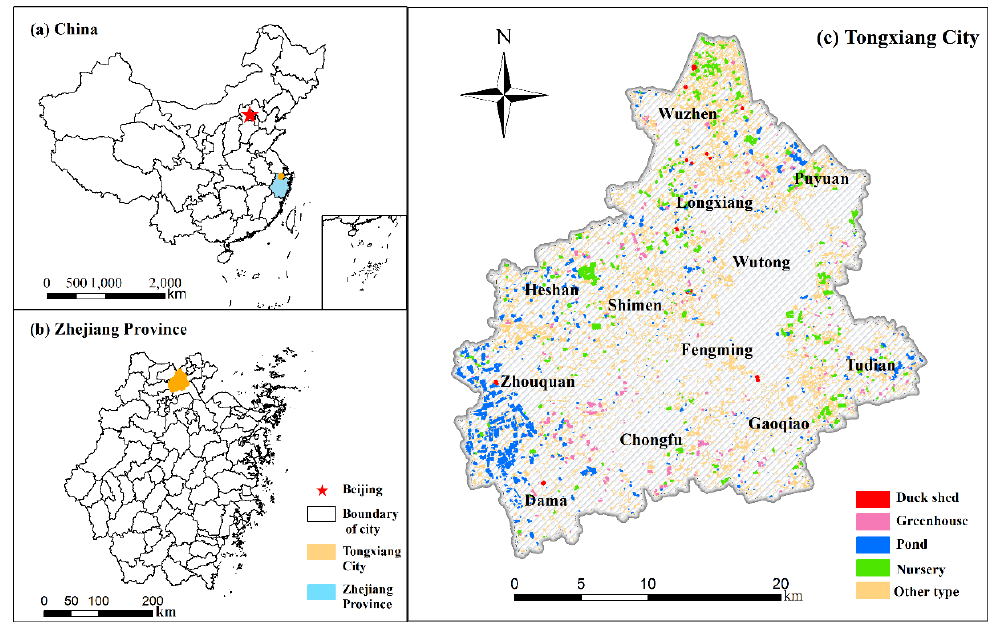
Figure 1. Location of the study area: ( a ) The location of Tongxiang City in China. ( b ) The location of Tongxiang City in Zhejiang Province. ( c ) The development of NGP in Tongxiang City in 2019.